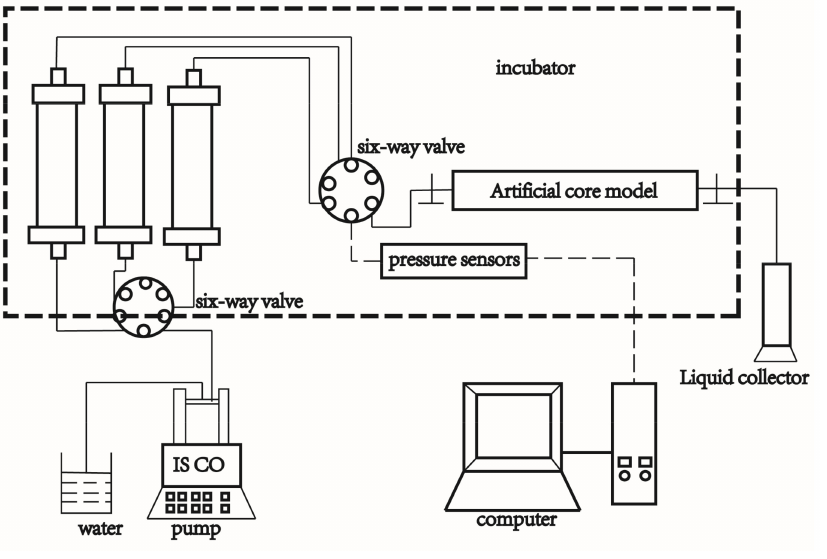
Figure 8. Diagram of the core displacement